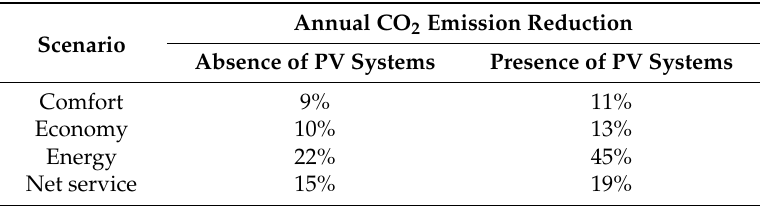
Table 13. Rome—CO 2 emission reduction with respect to the traditional scenario (S.0).